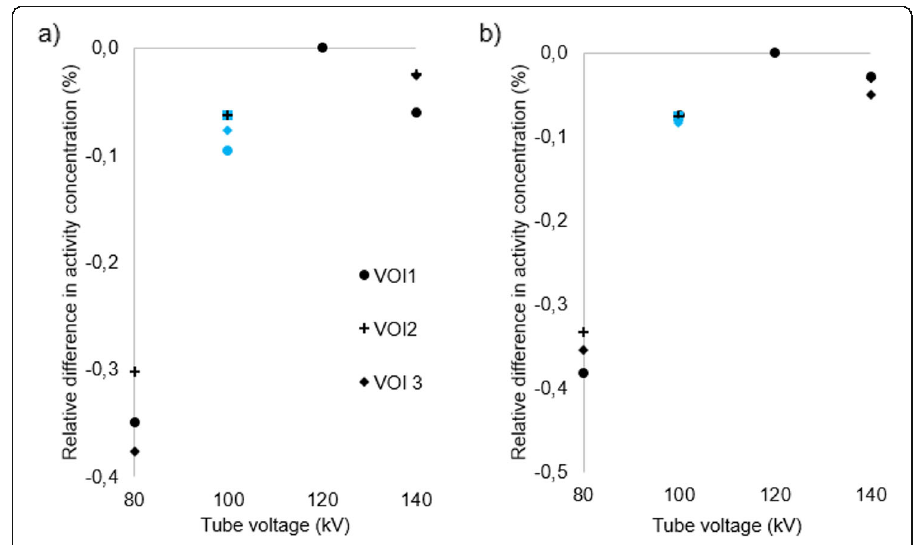
Fig. 5 Differences in a maximum and b mean activity concentration for each kV relative to 120 kV reference in Esser phantom. Data points also corresponding to ‘ CARE kV on ’ shown with blue markers